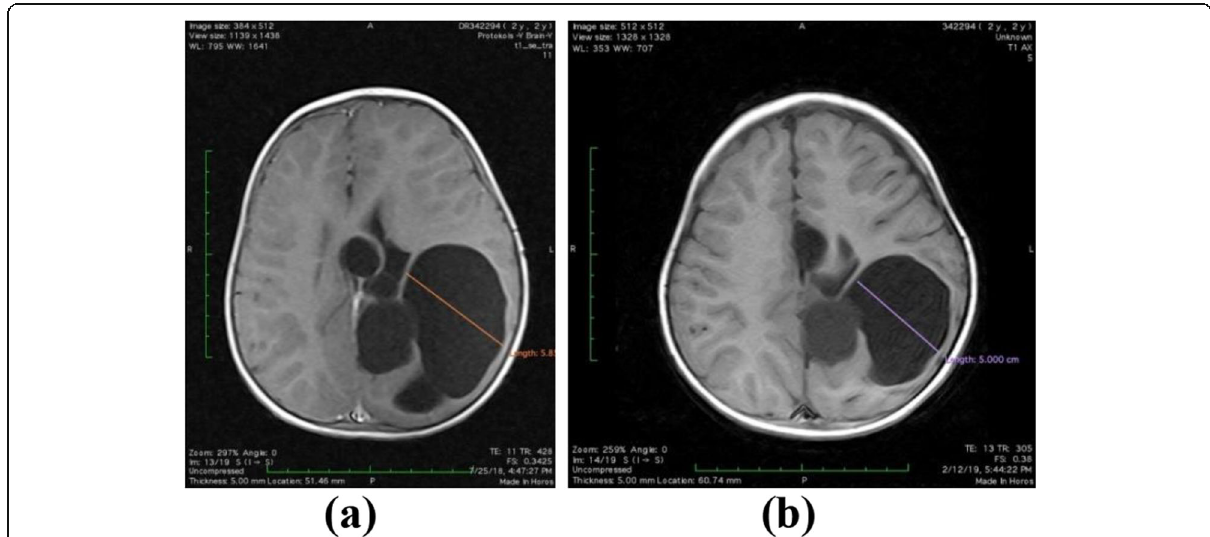
Fig. 8 a MRI T1 axial sequence showing left parietal paraxial arachnoid cyst effacing the lateral ventricle in a 1-year-old female. b MRI T1 axial sequence showing a decrease of the size of the cyst after 1-year follow-up. The procedure applied was endoscopic cystoventriculostomy through the left parietal burr hole